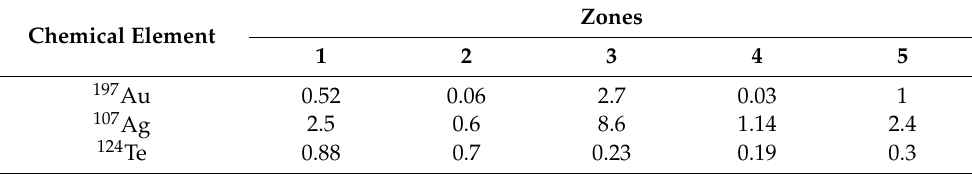
Table 9. Average concentration of Au, Ag and Te (ppm) in the zones of the pyrite grain. Zones Chemical Element 1